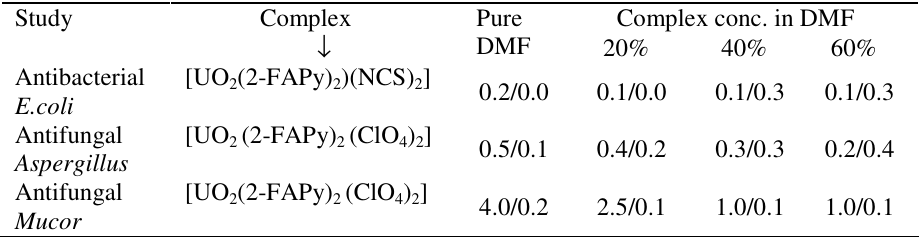
Table 6. Colony diameter/ radial distance of colony around sample disc